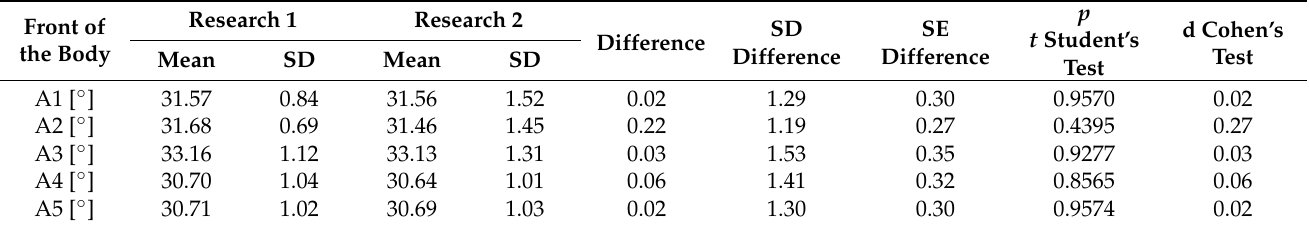
Table 1. Anterior surface temperature of the body measured before and after stimulation.